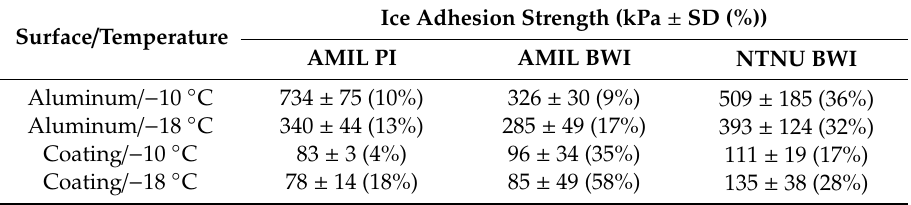
Figure 4. Measured ice adhesion strengths. Aluminum surfaces are denoted as Al, while the surfaces with icephobic coating are denoted as IC. All three ice types created are shown for each surface-temperature combination. Data displayed in Table 1. Table 1. Overview of mean values and standard deviations of ice adhesion strength. Data illustrated in Figure 4, with all data available in the supplementary information.